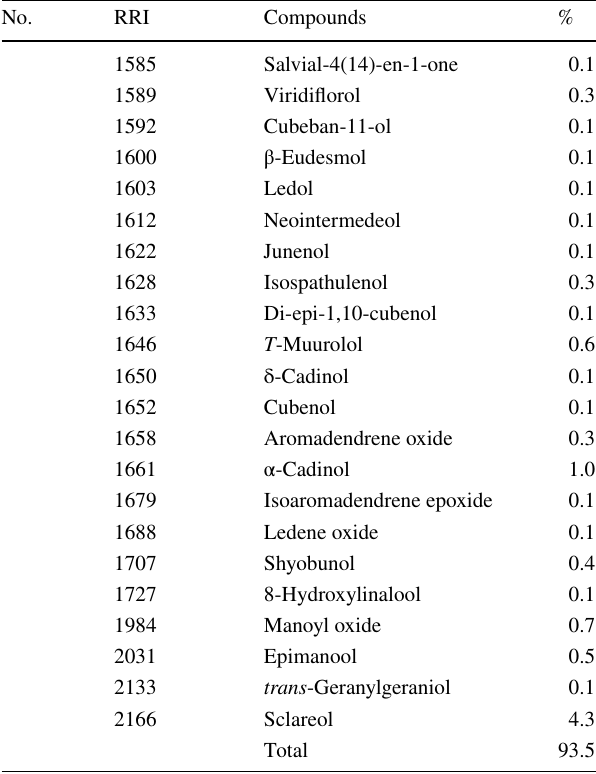
Table 2 Cytotoxic activity (IC Sample